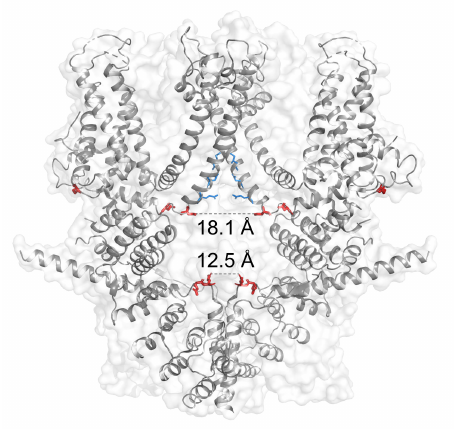
Figure 3. ( Red sticks ) Residues responsible for Mg 2 + and spermine-mediated inward-rectification of TRPC4. Distances in Angstrom between D629 residues (18.1) and E728 residues (12.5) are shown. ( Blue sticks ) Residues responsible for putative inner gate of the channel: I617, N621, and